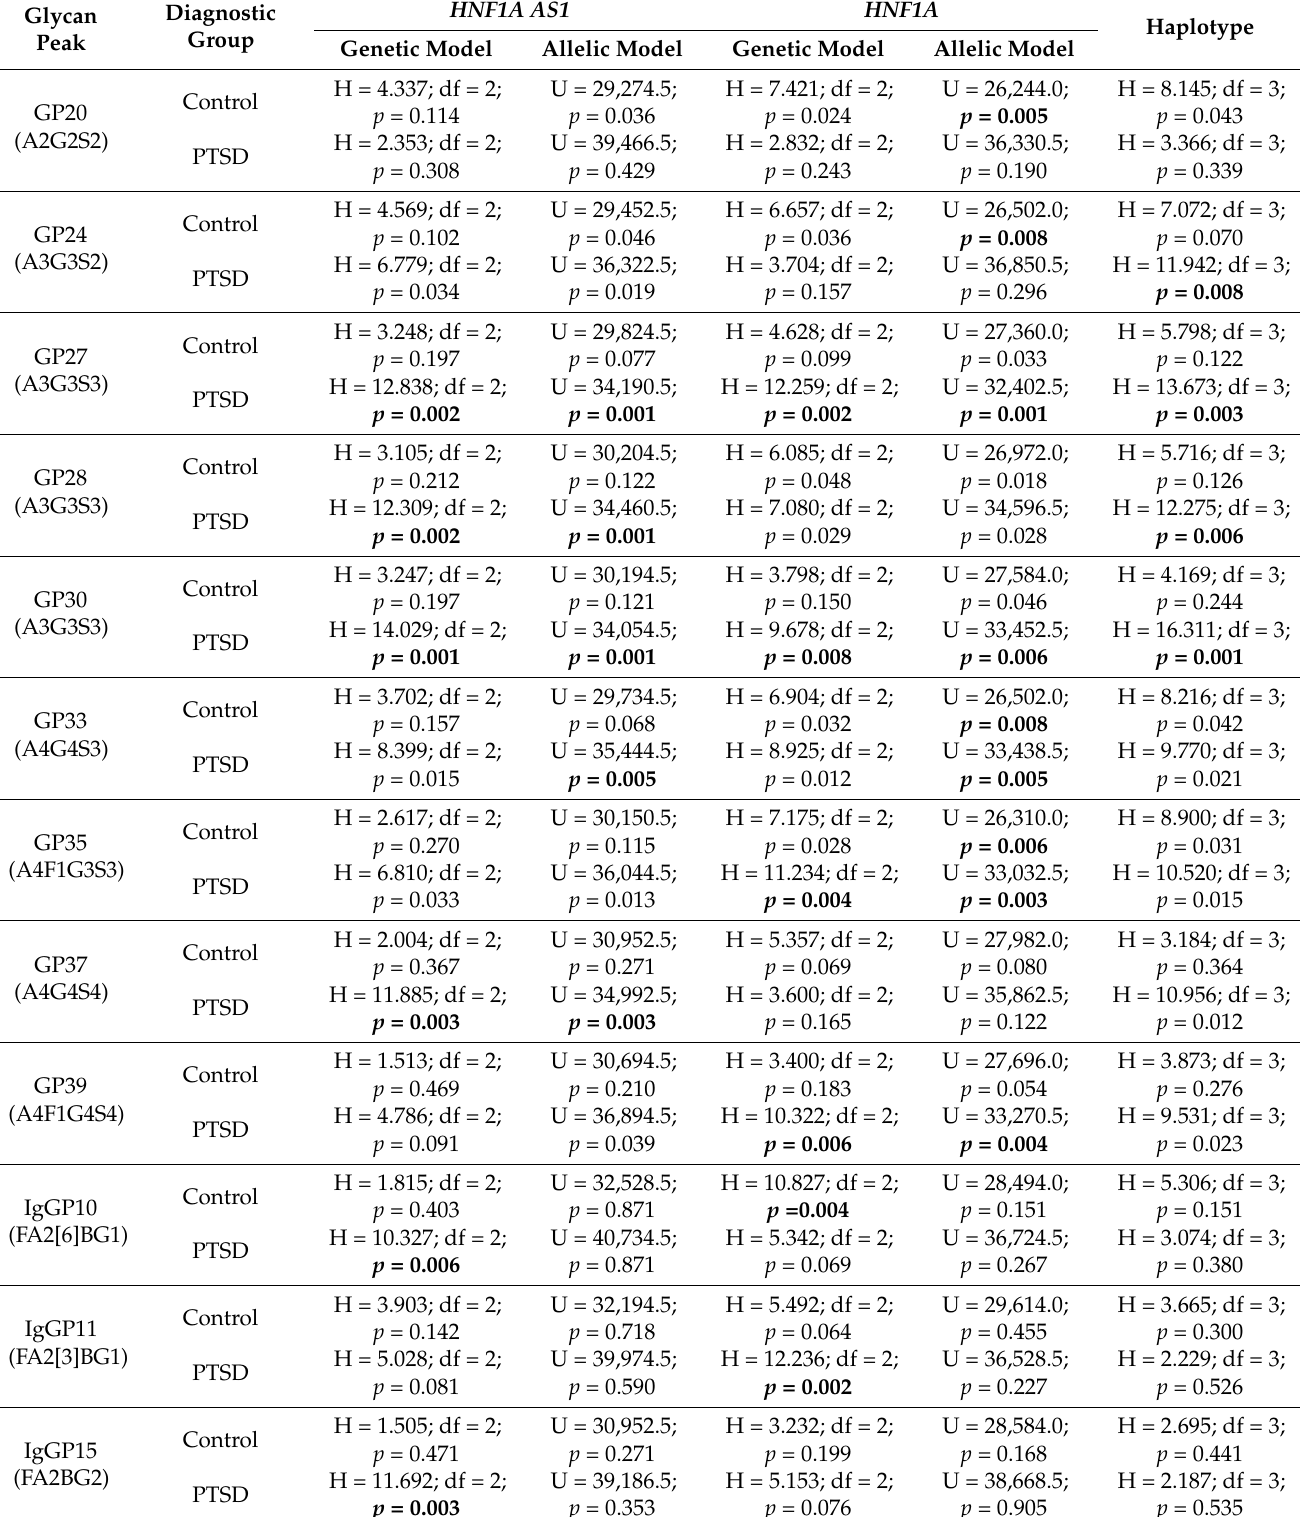
Table 4. Associations between the HNF1A-AS1 rs7953249 and the HNF1A rs735396 polymorphisms and the N-glycans in control subjects and patients with